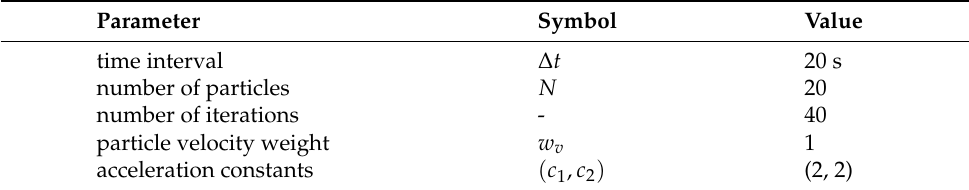
Table 3. Parameters of